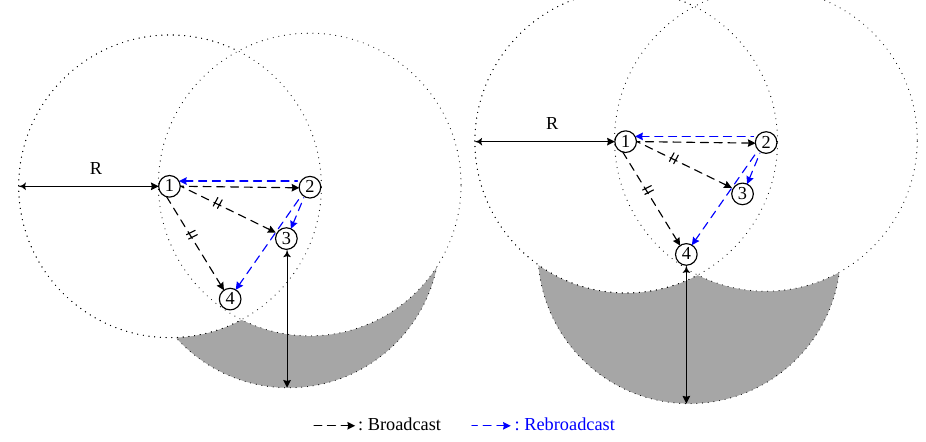
Figure 4. Different additional coverage areas of node 3 and node